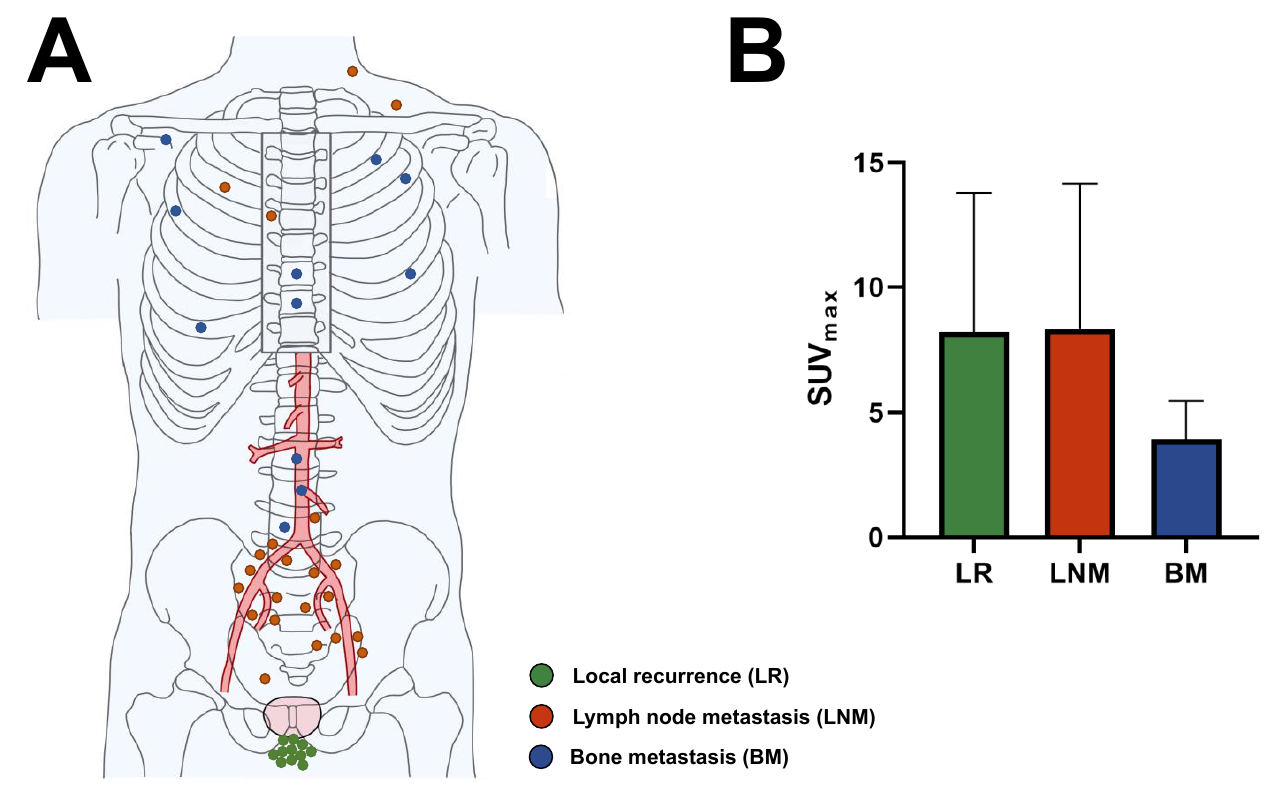
Figure 2. Characteristics of lesions suspicious for prostate cancer on 68 Ga-PSMA-11 PET/CT in men with BCR and very low PSA concentration (N = 115). ( A ) Anatomic location and putative category of lesions ( n = 44). Dots represent a single lesion and are color-coded as to putative category. ( B ) Descriptive statistics of SUV max by suspicious lesion category. SUV max does not differ ( p = 0.87) between presumed local recurrences ( n = 11) and lymph node metastases ( n = 22) but is significantly lower ( p < 0.01) for putative bone metastases ( n = 11) than for the other lesion categories.